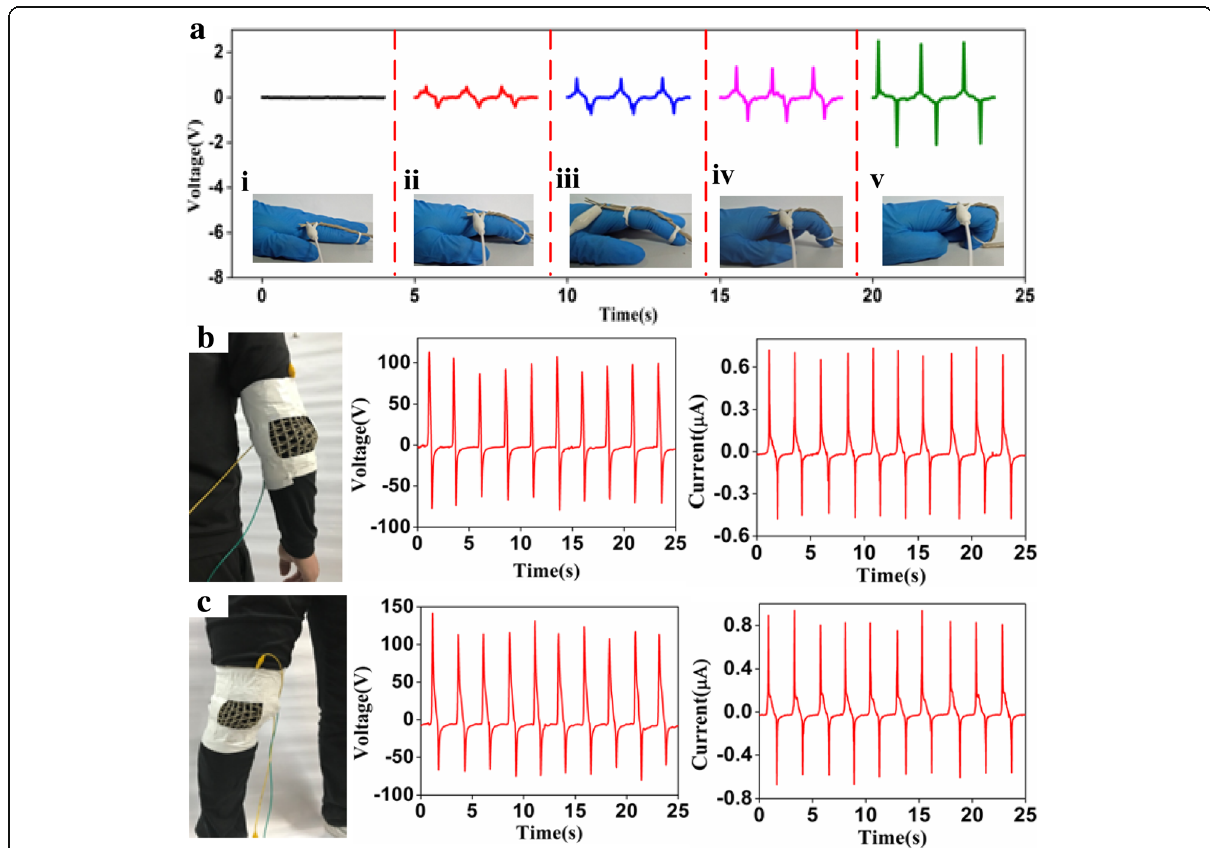
Fig. 5 a The SATT as a self-powered active sensor for detecting finger motion states. b The SPST is fixed on the elbow c the knee to perform energy harvesting and condition